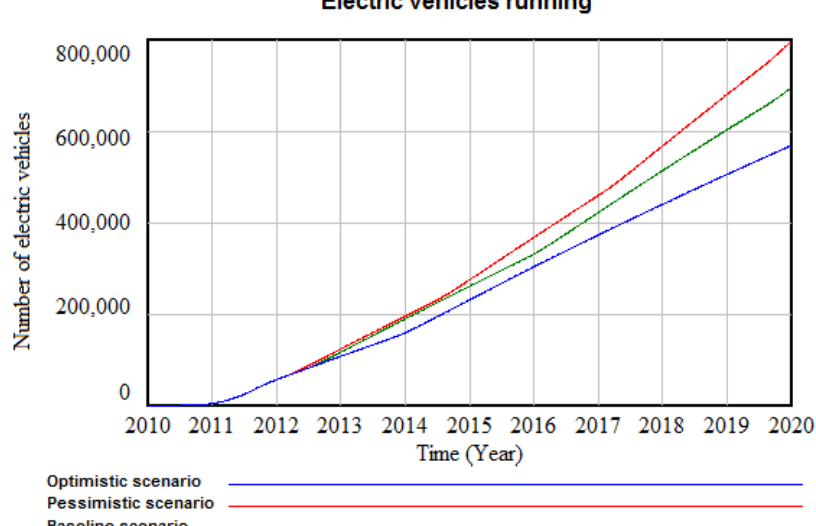
Figure 12. Electric vehicles on roads for the optimistic, pessimistic and baseline scenarios (the authors’